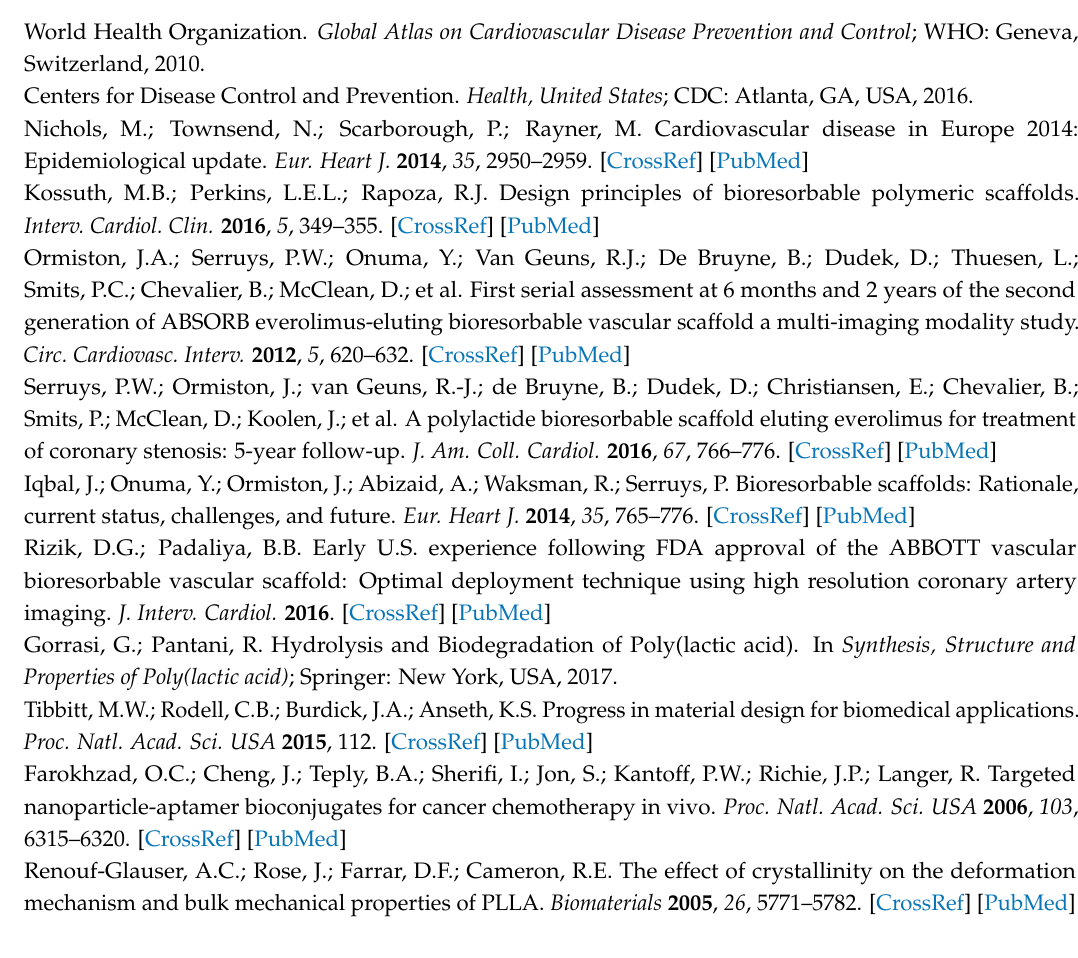
Figure S1: Selection of lamp orientation relative to the preform, Figures S2 and S3 & Table S1: Numerical simulations of the temperature profile of the preform, Figure S4: Experimental data used to validate the simulations, Figure S5: Implementation of the instrument at an X-ray beamline, Figures S6–S10: X-ray scattering analysis, Figures S11–S20: Summary of in situ WAXS and SAXS data, Figures S21 and S22: Quantitative analysis of in situ WAXS and SAXS